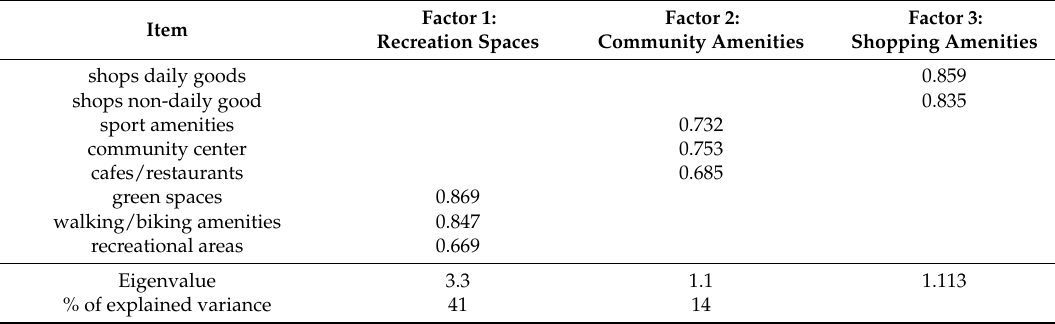
Table 3. Principal component analysis locations for social